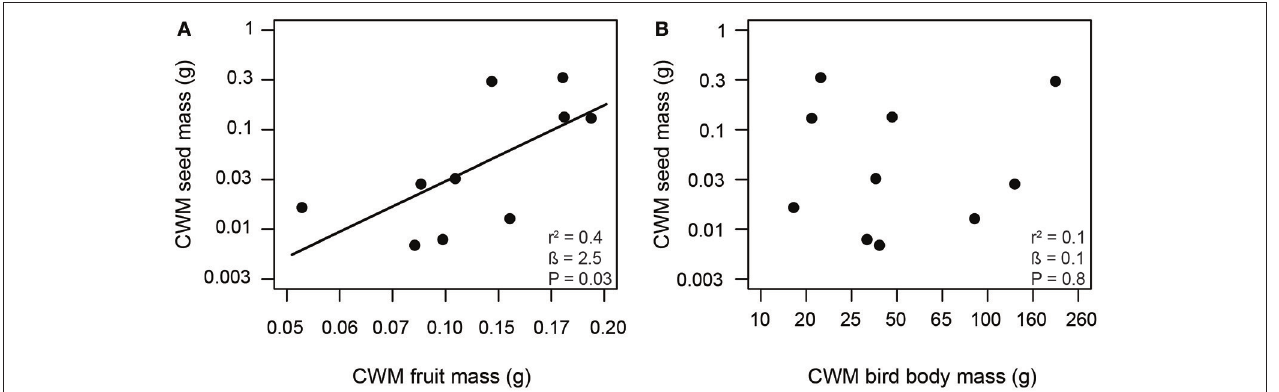
FIGURE 3 | Positive relationship between (A) fruit mass of adult plants and seed mass of recruited seedlings, and a lack of a relationship (B) between avian body mass and seed mass across 10 study plots in the Colombian Andes (elevational range: 1,800m to 2,700m a.s.l.). Trait values correspond to the community-weighted means (CWM) of the respective communities. Shown are results from linear regression models. Given are the overall model fit ( r 2 ) and the estimated slope ( β ) with its associated P -value; the solid line indicates a significant